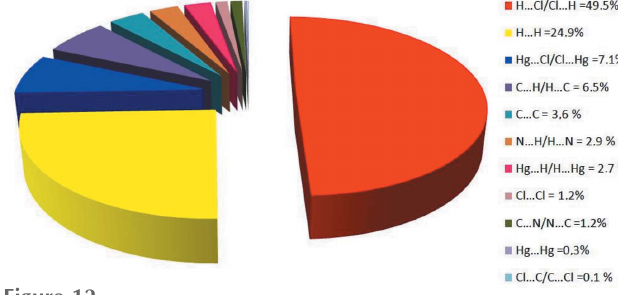
Figure 12 Relative contribution (%) of various intermolecular interactions to the Hirshfeld surface